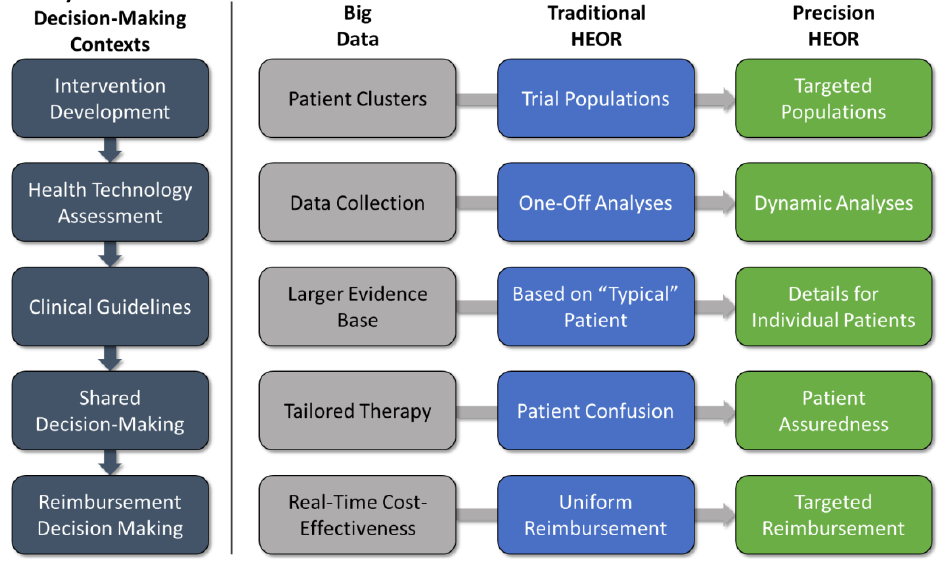
Figure 2. Big data impacts on HEOR.